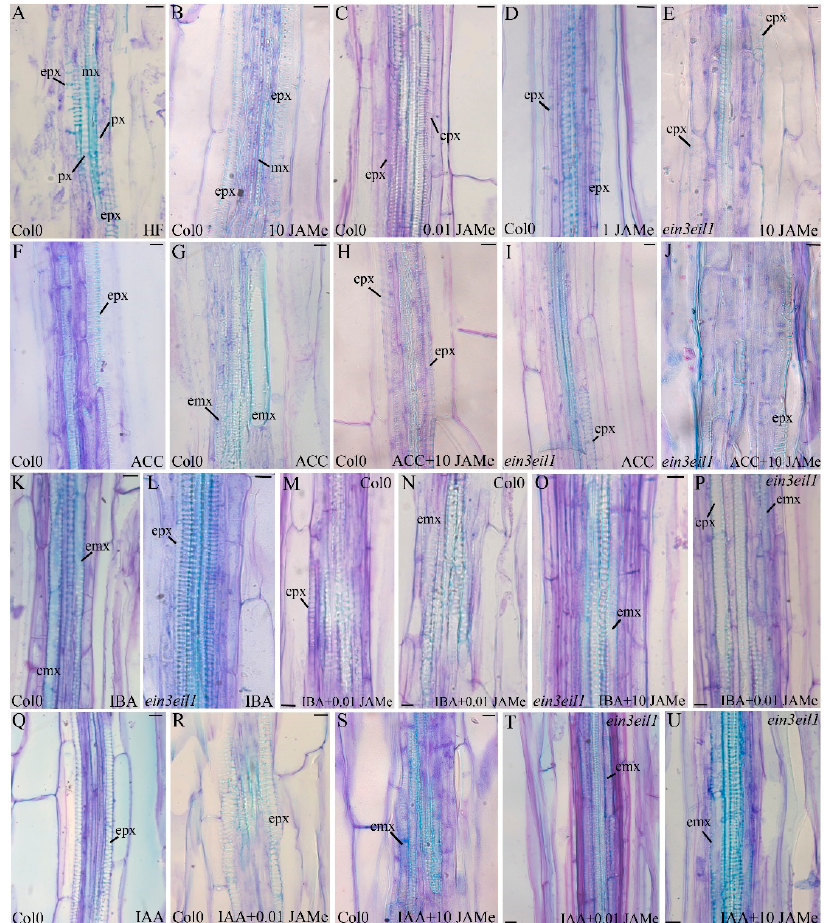
Figure 2. Xylogenesis in the basal hypocotyl of Arabidopsis Col-0 (wt) and ein3eil1 double mutant seedlings dark-grown for 22 DAS with di ff erent